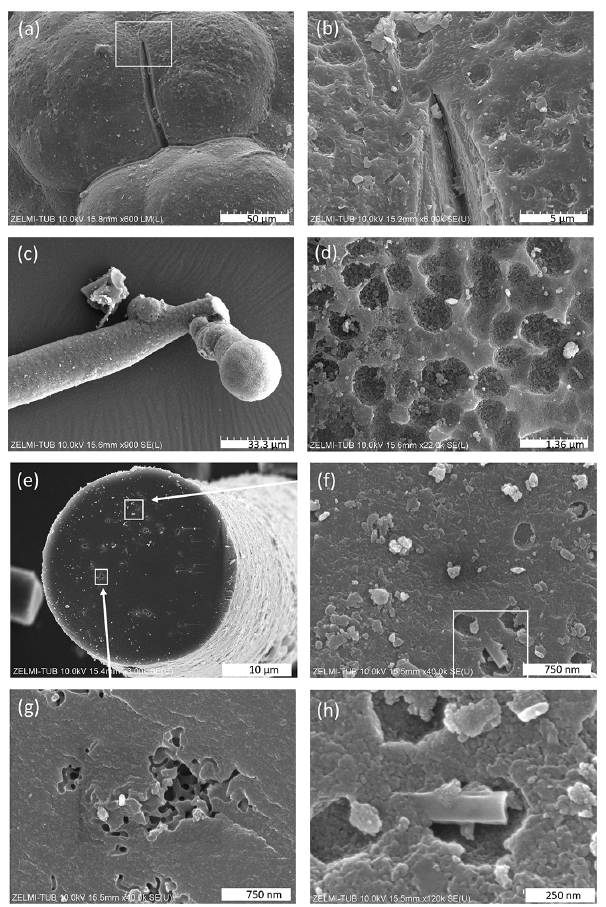
Figure 6. SEM images of broken filaments showing a central chan- nel. (a) Six-sided channel with dimensions 260nm × 550nm of fil- ament with a smooth surface and fringe fractures on the broken face, indicating brittle behavior. (b) Double channel, probably ini- tial crosscutting of a branching (cf. Fig. 4d). (c) Similar channel as in (a) but with a less regular outline (all sample #0). (d) Filament with a central part, a sheath-like outer part, and a channel; num- bers refer to analysis points (see text; EDS spectra in Fig. S4). Note dented surface in lower part of the sheath-like outer part (sample #5). (e) Filament with a rough surface and a channel 4µm × 11µm. (f) Large, ca. 25µm wide channel with six-sided outline (both sam- ple #5). (g, h) Filaments with encrustations of clay minerals and six-sided channels (sample